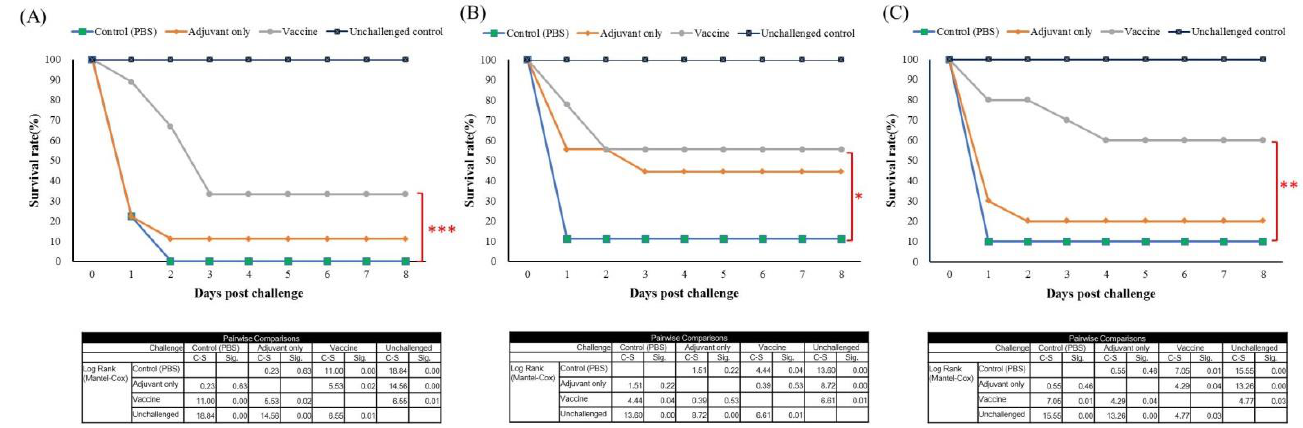
Figure 5. Kaplan – Meier survival curves for Oplegnathus punctatus vaccinated with phosphate-buffered saline (PBS), adjuvant ISA763A, or bacterin and then challenged with Vibrio harveyi on day ( A) 14 ( n = 9), ( B ) 28( n = 9), or ( C ) 42 ( n = 10) post immunization. Differences between the groups were assessed using the Mantel – Cox test for pairwise comparisons. * p < 0.05; ** p < 0.01; *** p < 0.001.